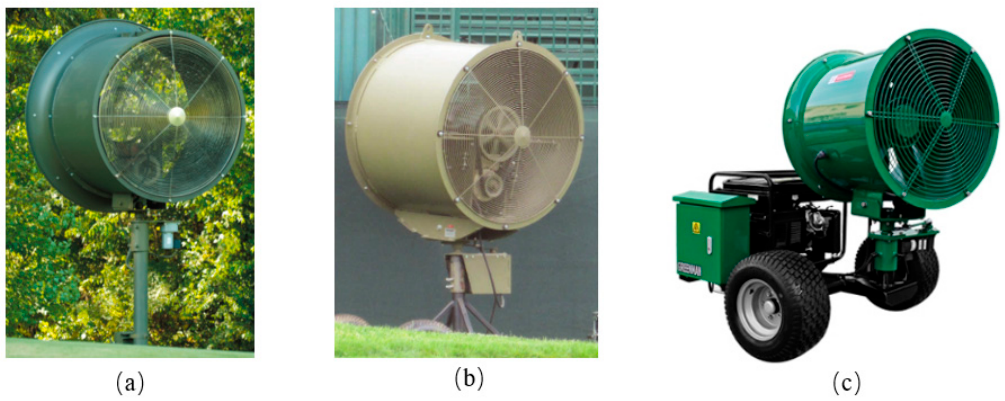
Figure 1. Cooling fans for green lawns. ( a )—Turf Breeze; ( b )—Breeze Master; ( c )—Greenman.